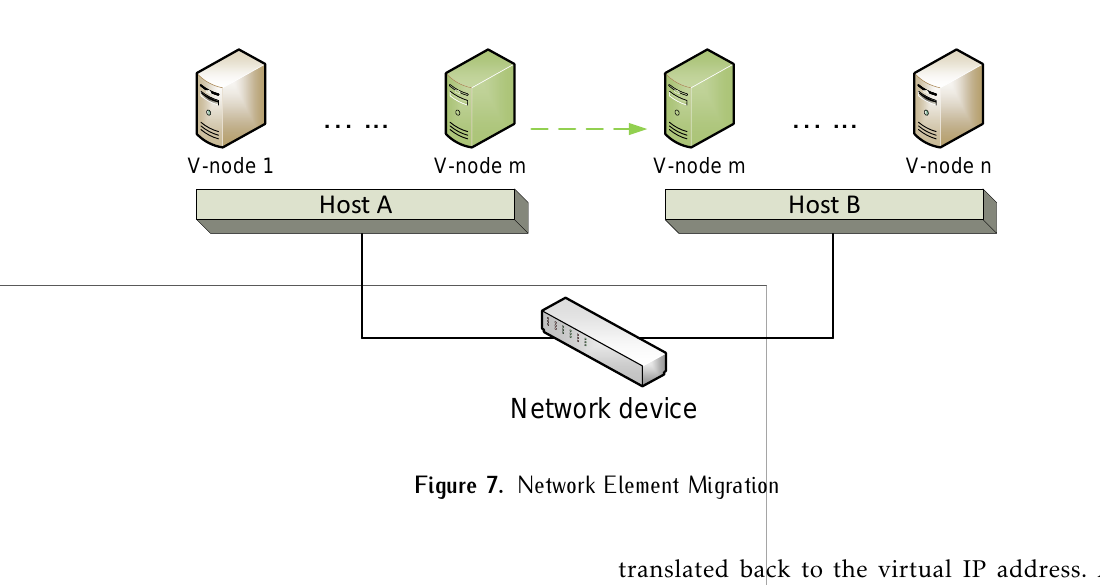
Figure 7. Network Element